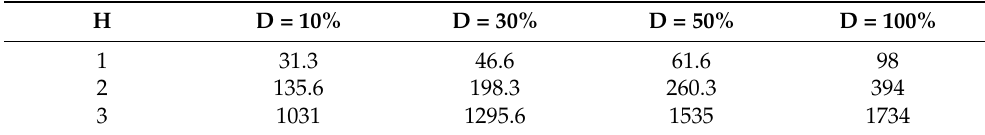
Table 10. Training time per epoch on MovieLens-1M (in